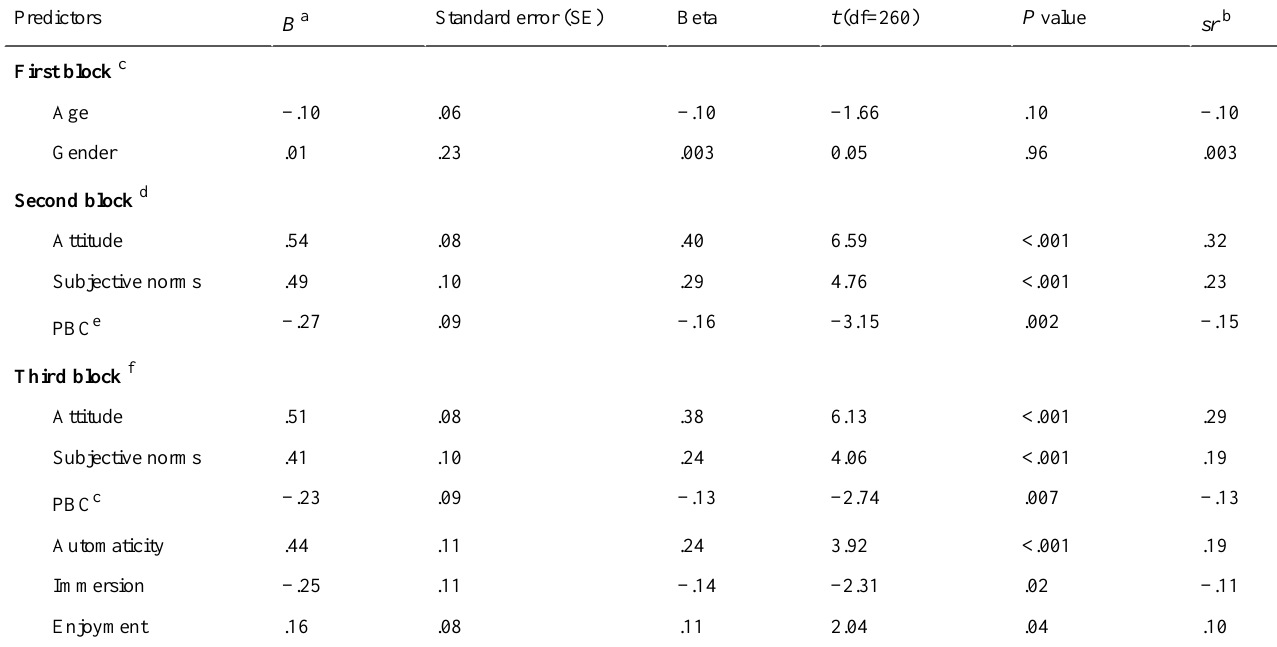
Table 5. Regression results for intention to play a mobile game while walking in study 1